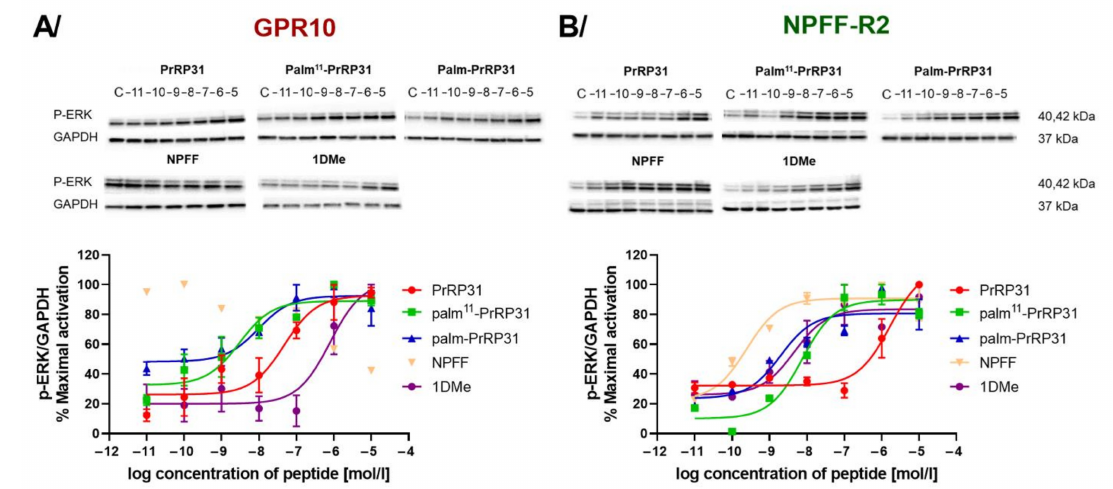
Figure 4. Dose-response phosphorylation of ERK in CHO-K1 cells expressing ( A ) GPR10 and ( B ) NPFF-R2 after 5 min of incubation at 37 ◦ C with peptides at final concentrations from 10 − 11 to 10 − 5 M. Densitometric quantification was normalized to GAPDH. Data are presented as the mean ± SEM, and the experiments were performed independently at least two times and were analyzed using nonlinear